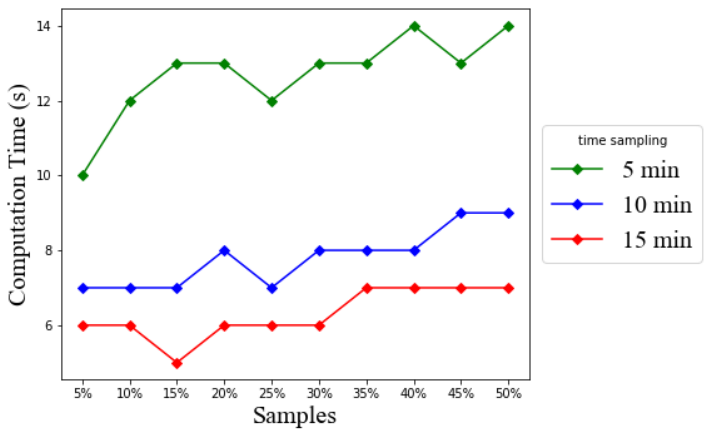
Figure 22. Computation time with varied time